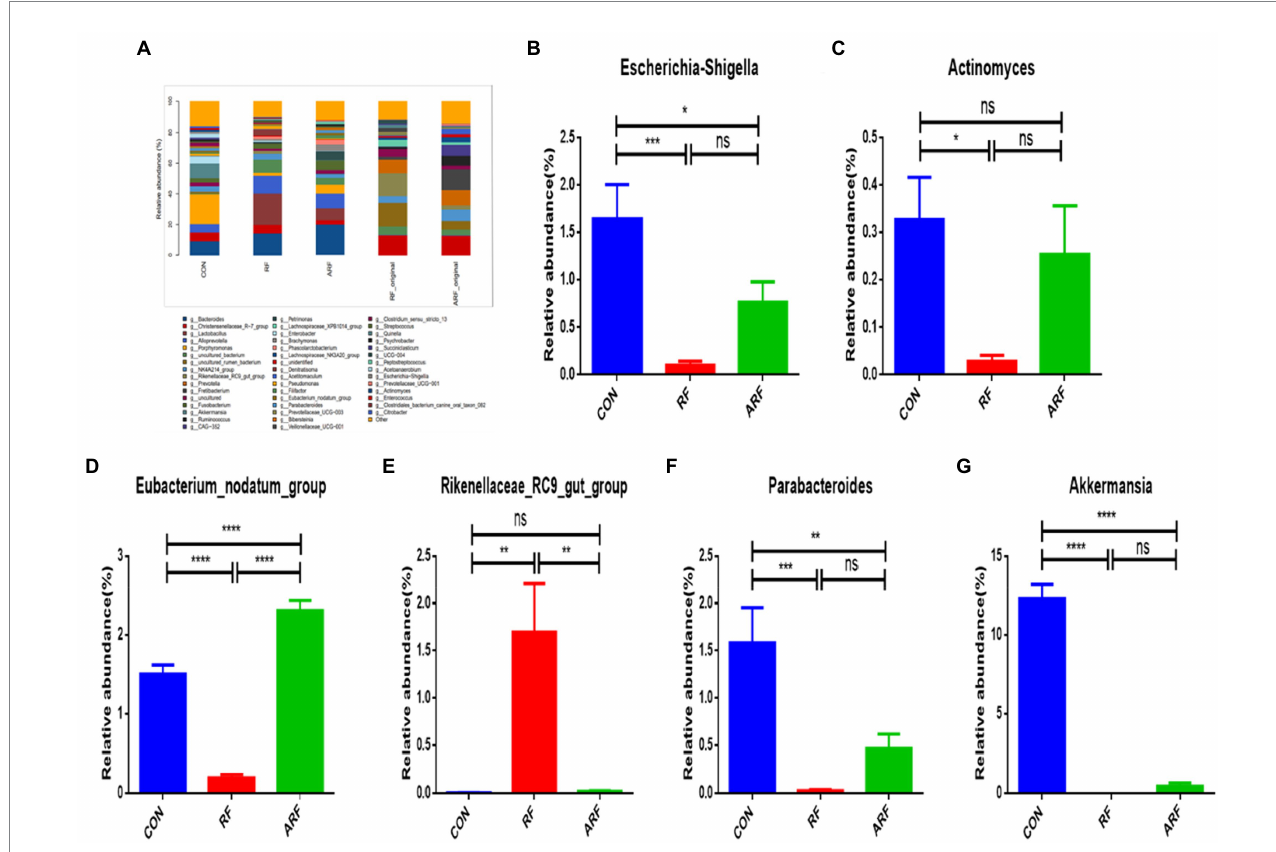
FIGURE 4 Relative abundance of microbiota at the genera level. (A) Microbiota taxonomic profiling of intestinal microbiota from different groups at the genera level which the abundance of the microbiota is more than 1%. (B) Ratio of Escherichia-Shigella in the three groups. (C) Ratio of Actinomyces in the three groups. (D) Ratio of Eubacterium_nodatum_group in the three groups. (E) Ratio of Rikenellaceae_RC9_gut_group in the three groups. (F) Ratio of Parabacteroides in the three groups. (G) Ratio of Clostridiales_bacterium_canine_oral_taxon_082 in the three groups. (H) Ratio of Akkermansia in the three groups. n =